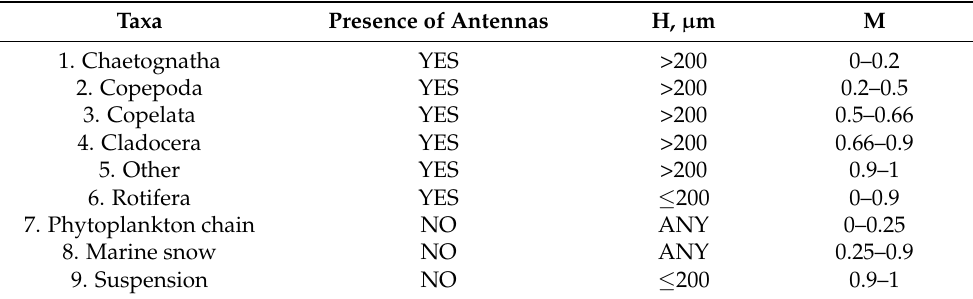
Table 3. Characteristic values of taxa for automatic classification of particles: M—morphological parameter; H—length of a rectangle circumscribed around the particle image. Taxa Presence of Antennas H, µ m